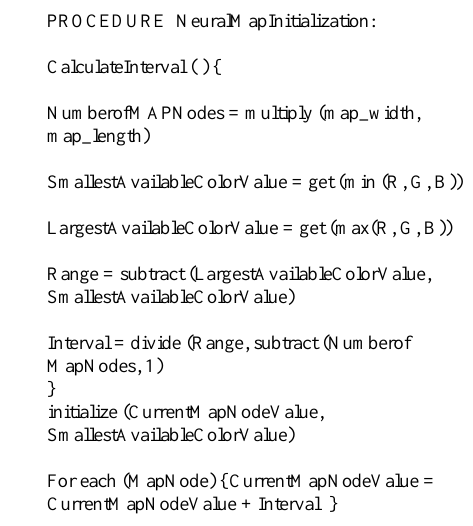
Figure 8. Pseudo-code of an interval computation for map node